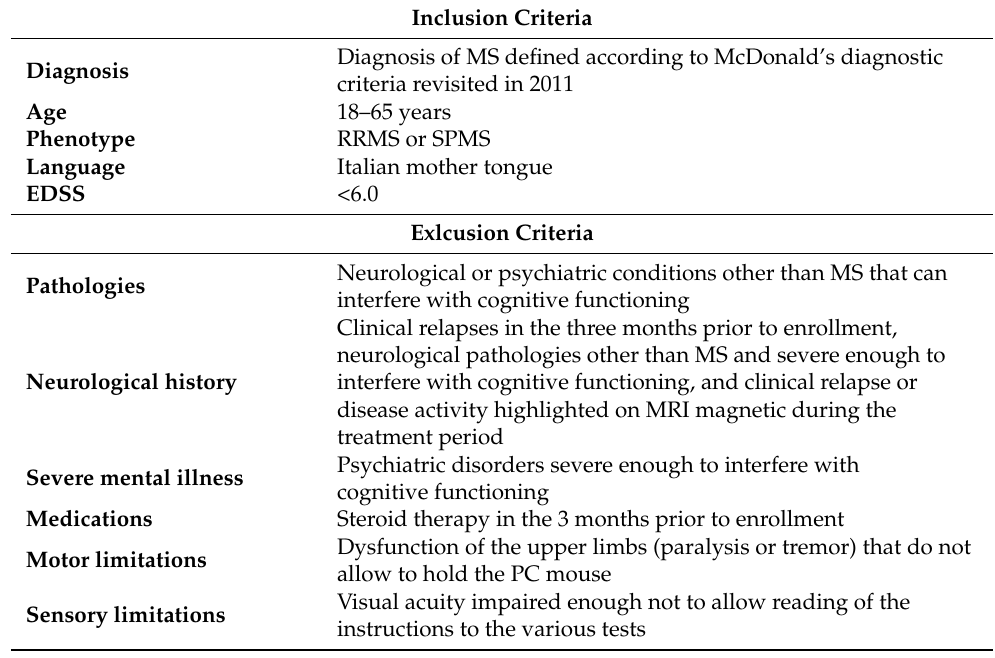
Table 1. Inclusion and exclusion criteria for the enrollment of patients. Inclusion